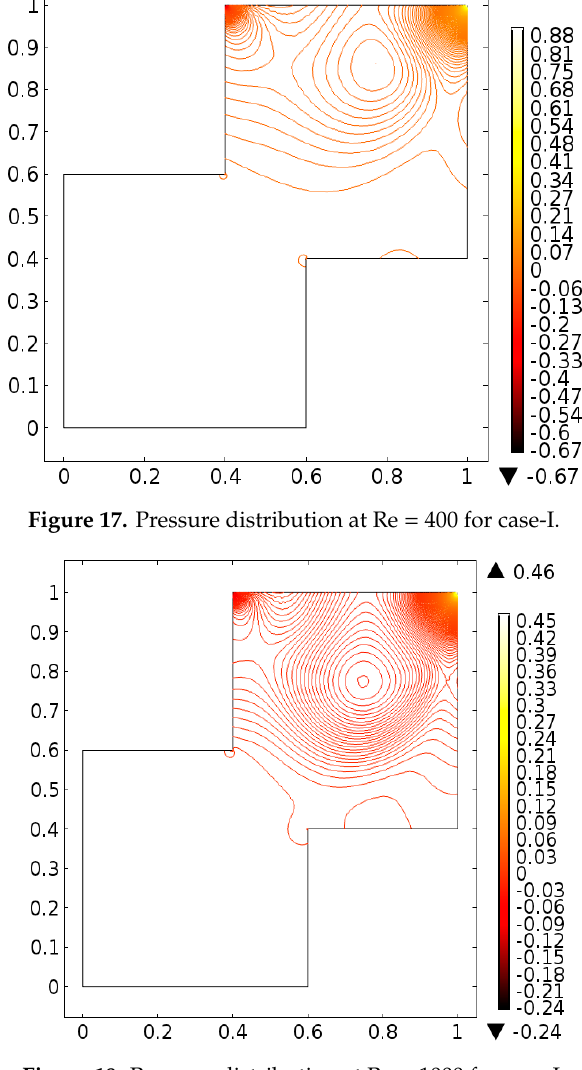
Figure 18. Pressure distribution at Re = 1000 for case-I.